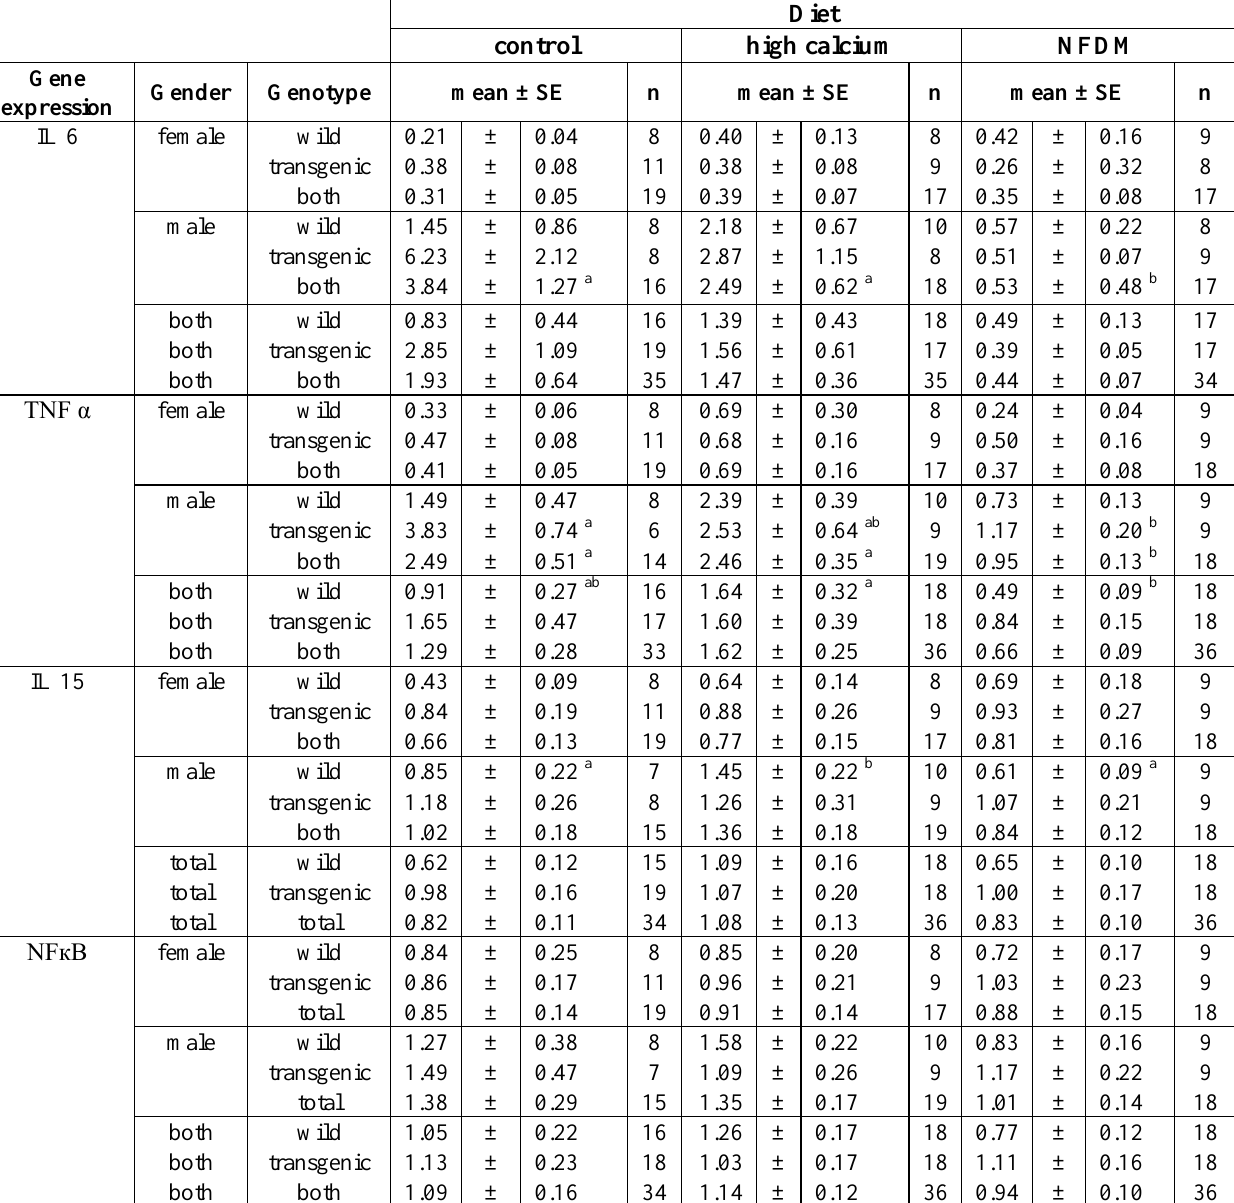
Table 5. Gene expression of IL6, IL15, TNF α and NFкB in inguinal fat tissue in aP2-agouti transgenic and wild-type mice fed control, high calcium or NFDM diets